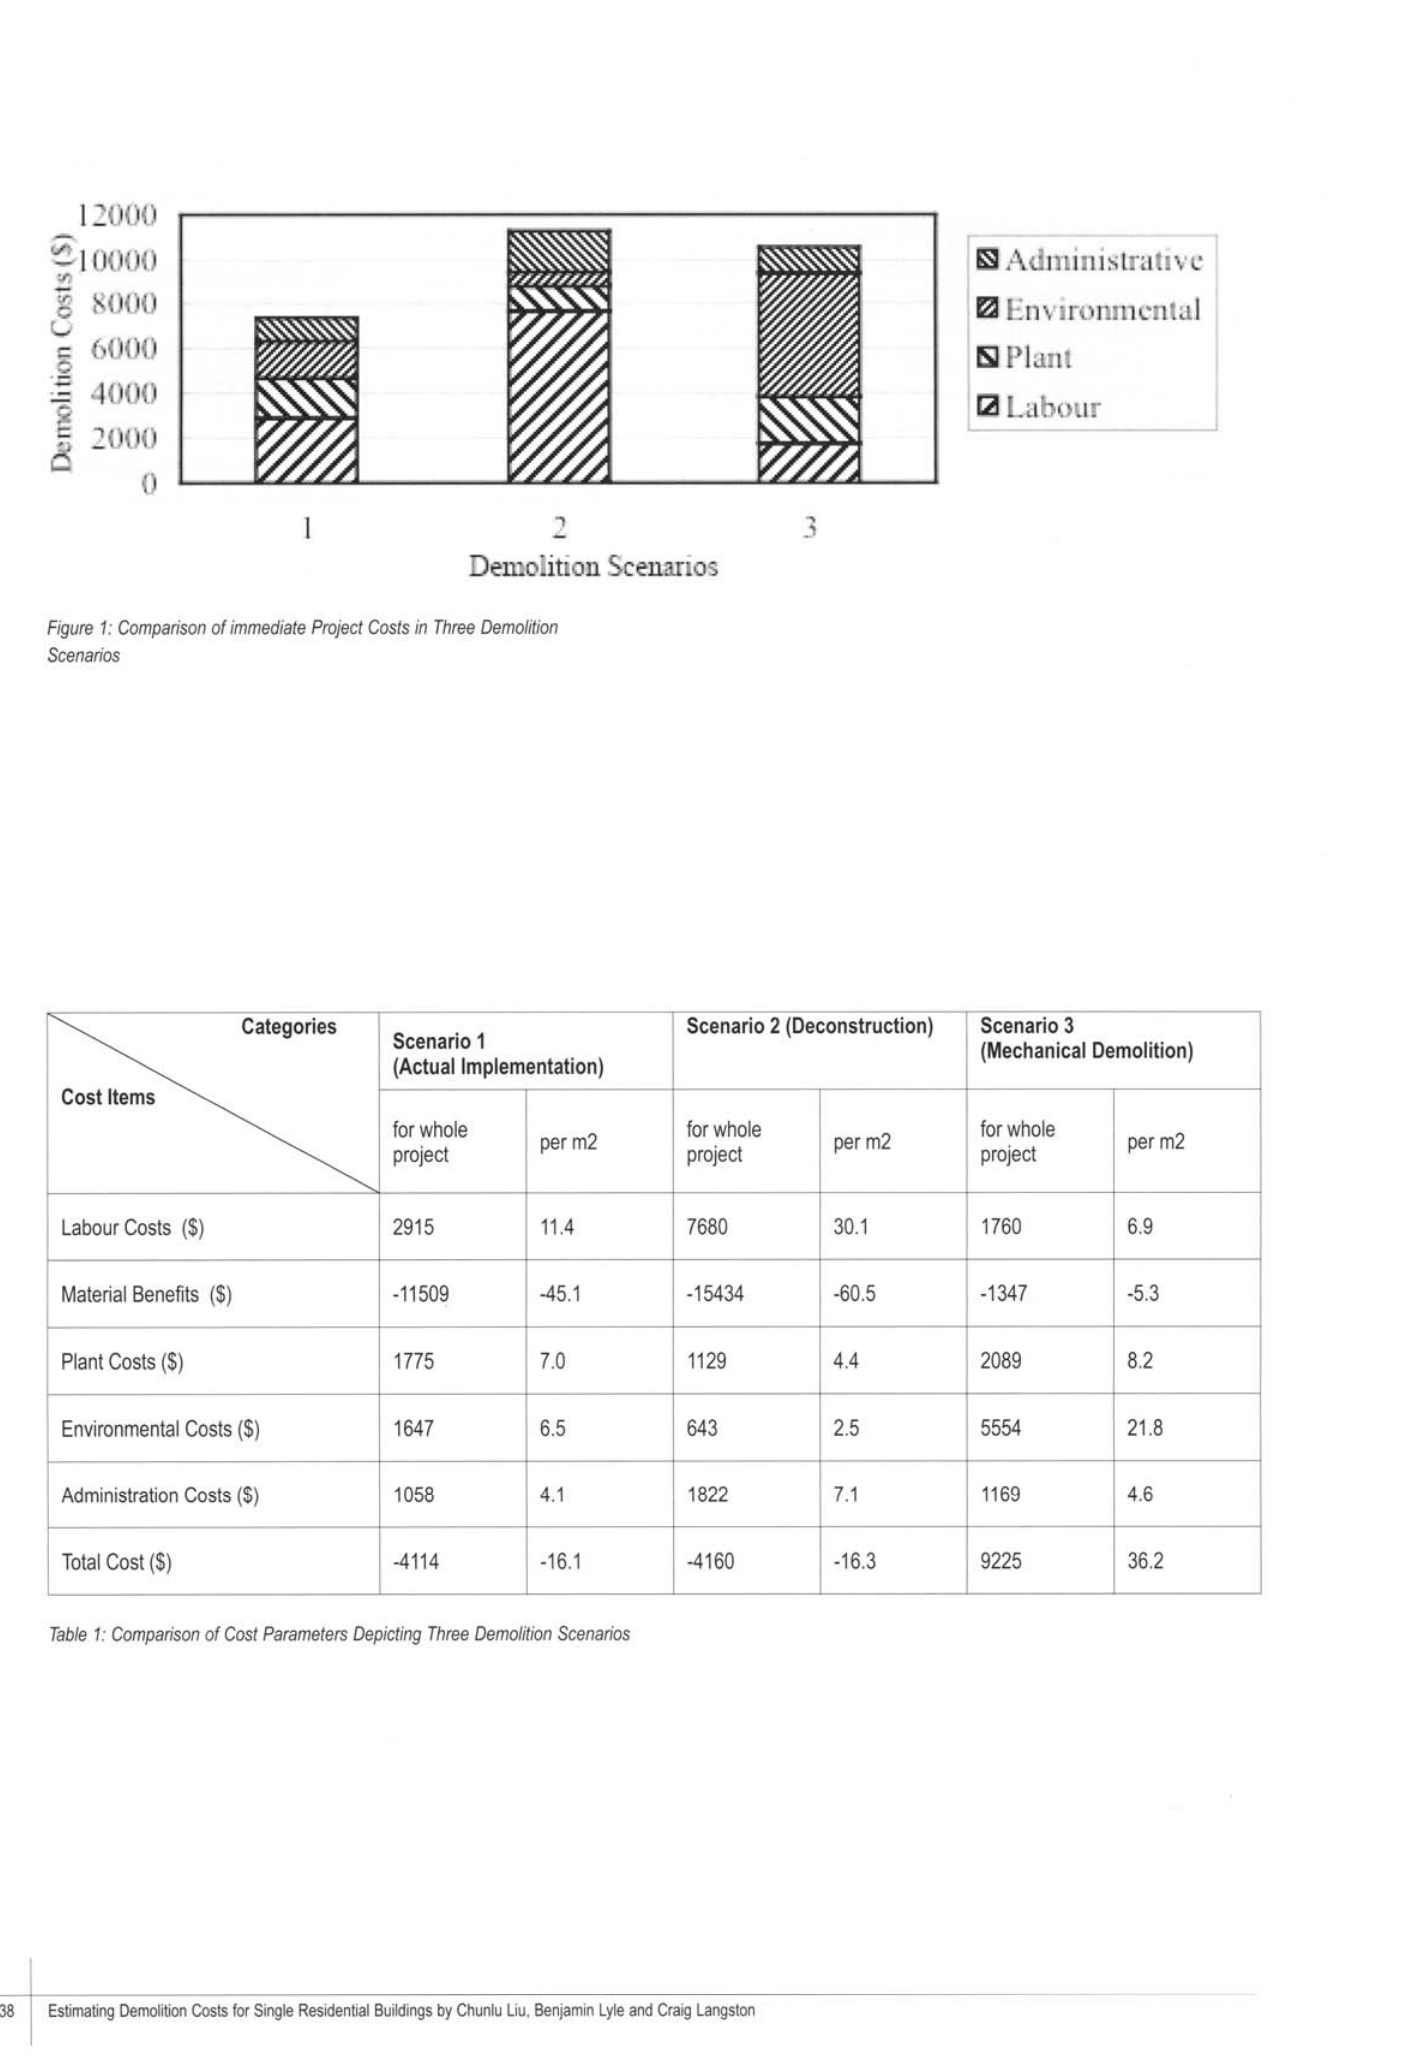
Figure 1: Comparison of immediate Project Costs in Three Demolition